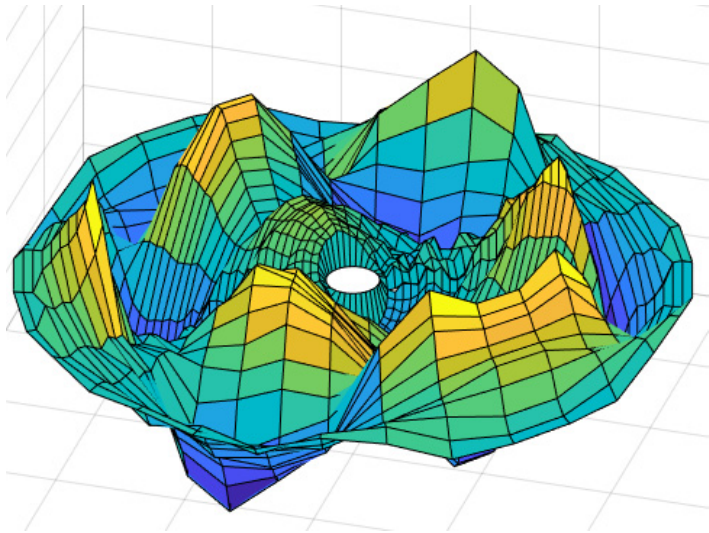
Figure 6. Time domain reflected E 3 field at a given time instant.